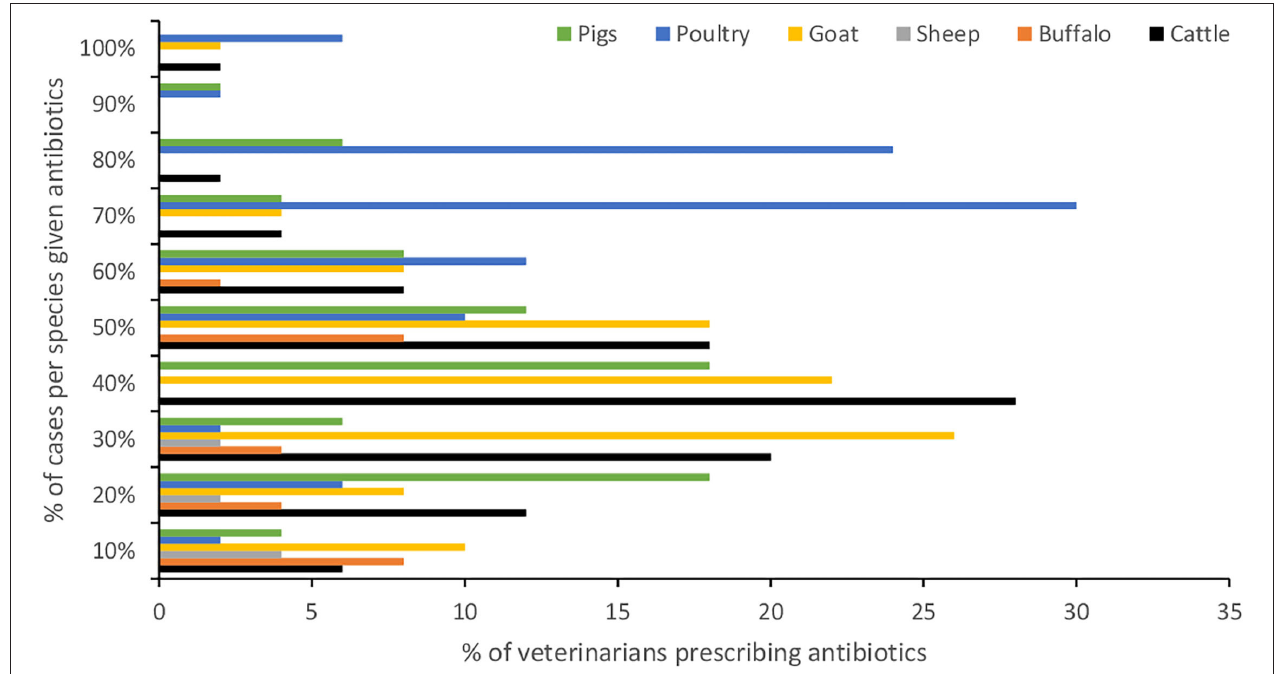
FIGURE 1 | Proportion of cases of different animal species for which antibiotics were prescribed by veterinarians.